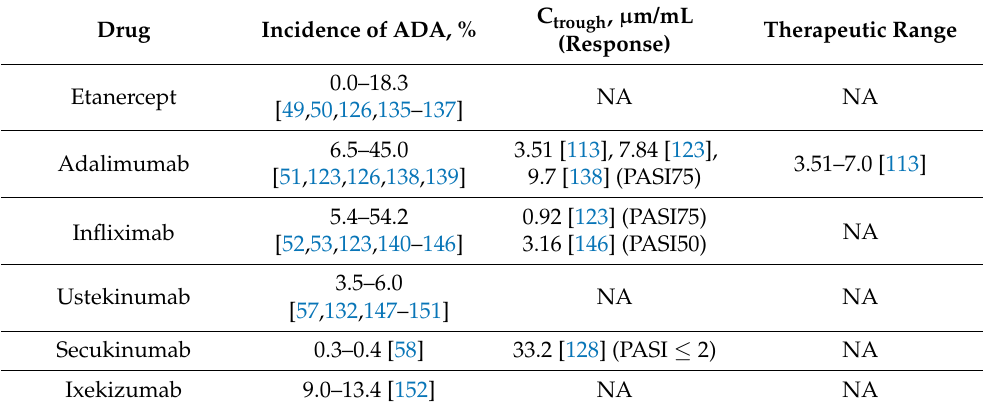
C trough , µ m/mL Therapeutic Range (Response)